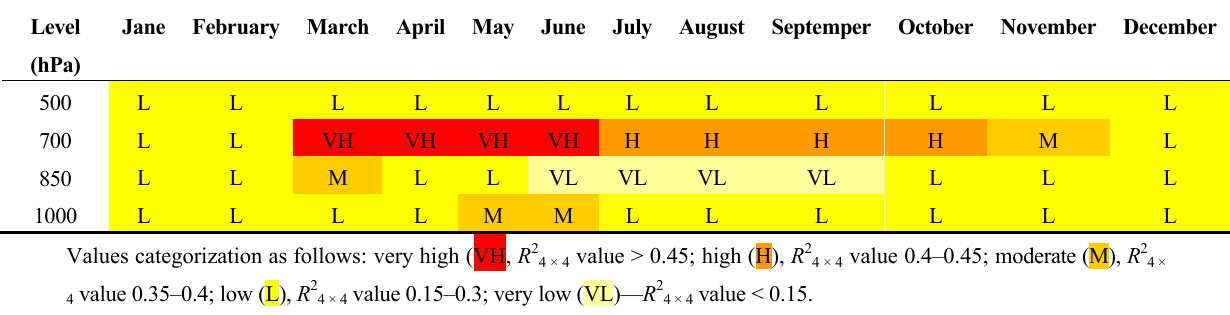
Values categorization as follows: very high (VH, R 2 4 × 4 value > 0.45; high (H), R 2 4 × 4 value 0.4–0.45; moderate (M), R 2 4